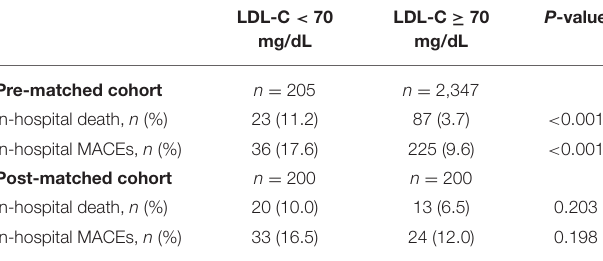
TABLE 2 | Association between LDL-C and clinical